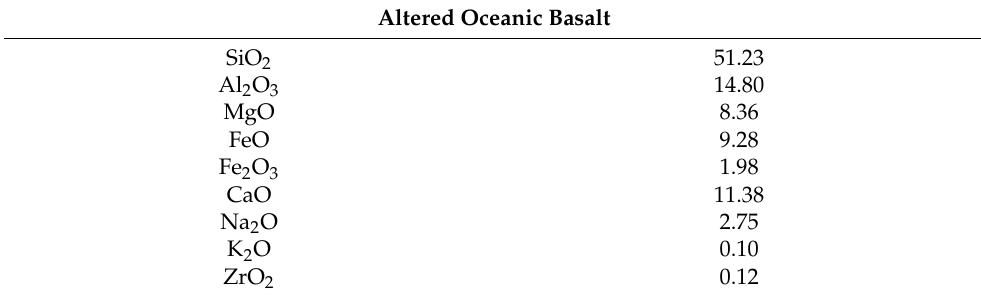
Table 1. Bulk rock compositions used in the modelling (in wt.%, H 2 O in